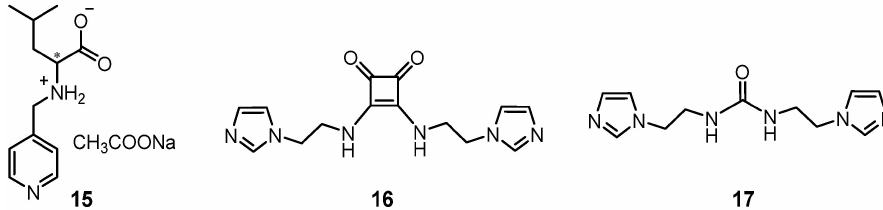
Figure 5. Structures of ligands 15 – 17 .